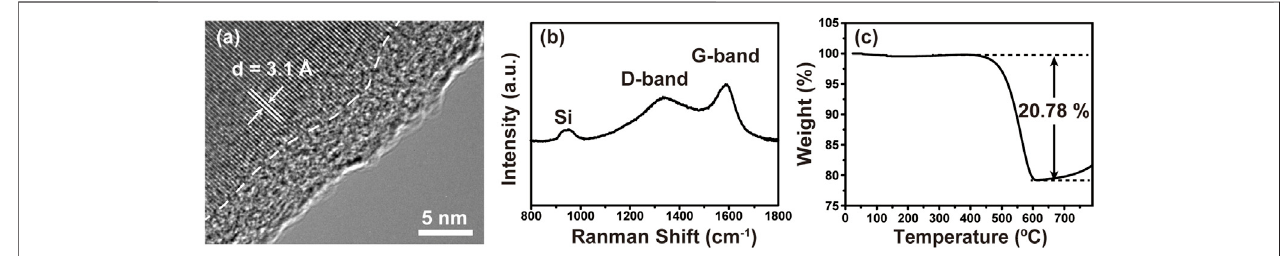
Frontiers in Chemistry |